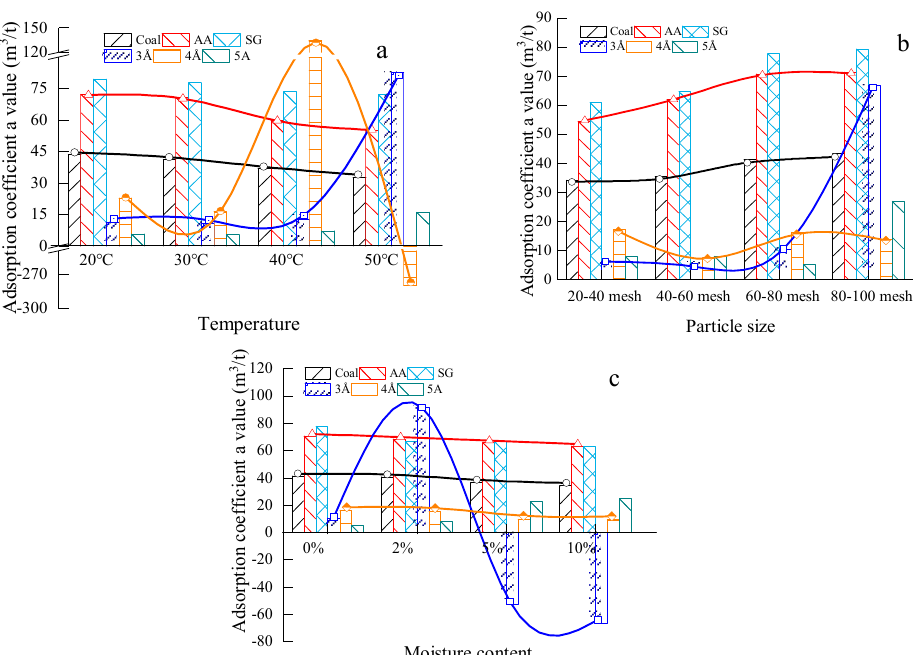
Figure 3. Adsorption coe ffi cient a values of testing materials in di ff erent factors: ( a ) Adsorption